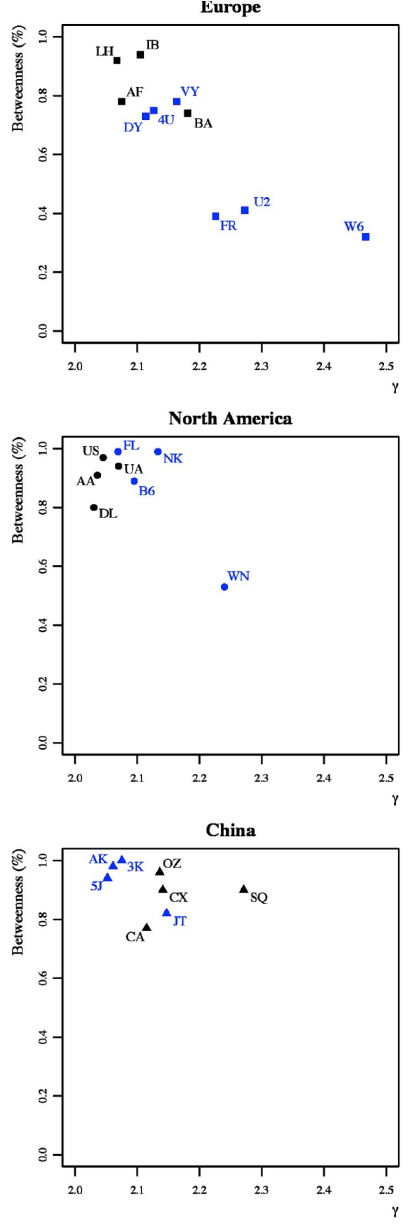
Figure 1. Betweenness centralization and γ for selected